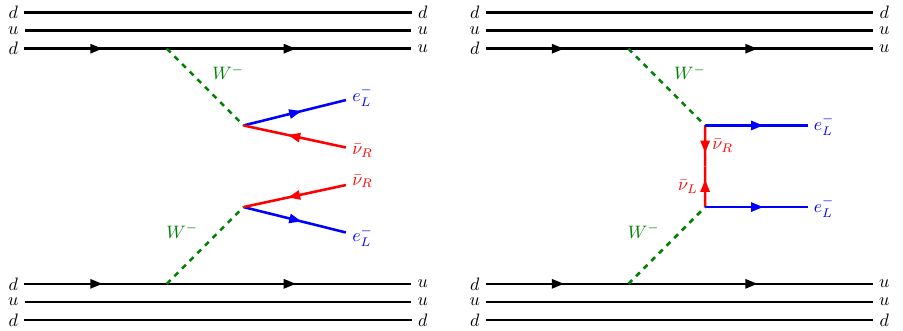
Figure 1. On the left , the diagram of the standard 2 νββ decay with the emission of 2 anti-neutrinos. On the right , the 0 νββ process due to the exchange of a light Majorana neutrino with lepton number